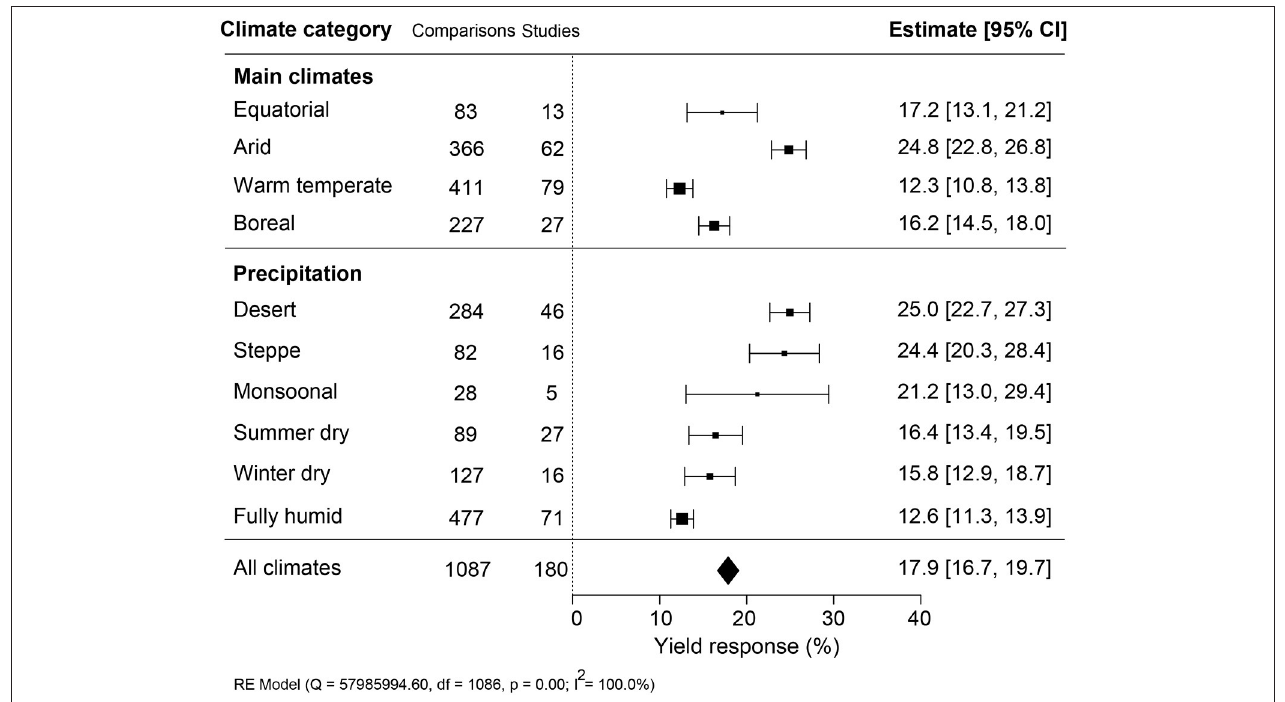
FIGURE 5 | Percentage yield response to biostimulant application affected by the climate categories that were subgrouped into main climates and precipitation types. The point size correlates to the estimate’s precision, and the error bars represent 95% confidence intervals (CI) of mean estimated effect sizes. The number of comparisons and studies is indicated in each line. The combined effect estimates and the heterogeneity test on the random-effect model (RE) were summarized at the bottom, where the heterogeneity test is significant ( p < 0.001) and I 2 ≥ 75% implies substantial